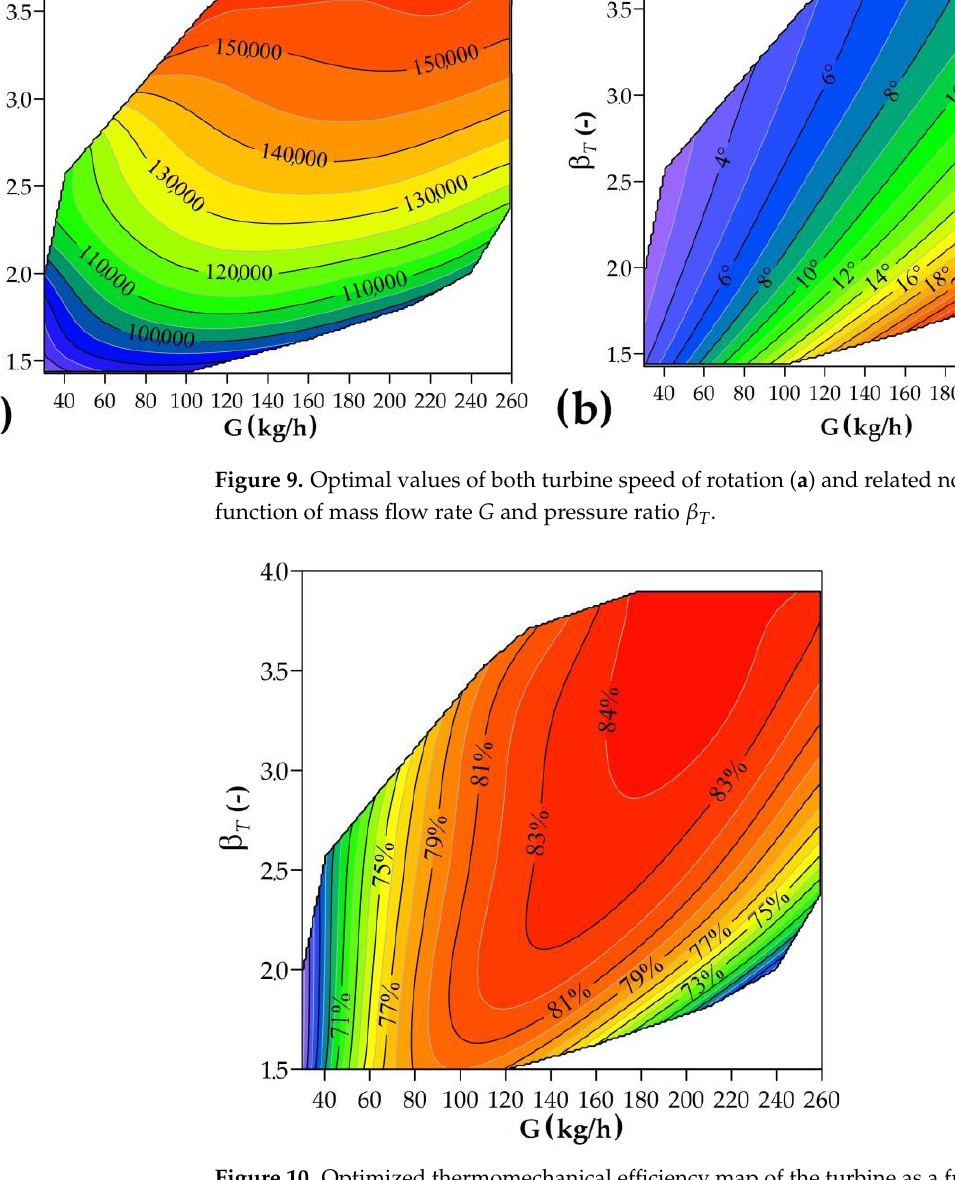
Figure 10. Optimized thermomechanical efficiency map of the turbine as a function of mass flow rate G and inlet pressure ratio β T .